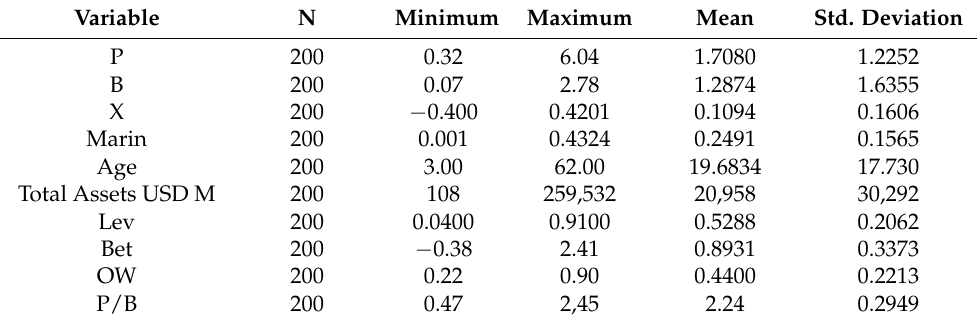
Table 3. Descriptive statics of the